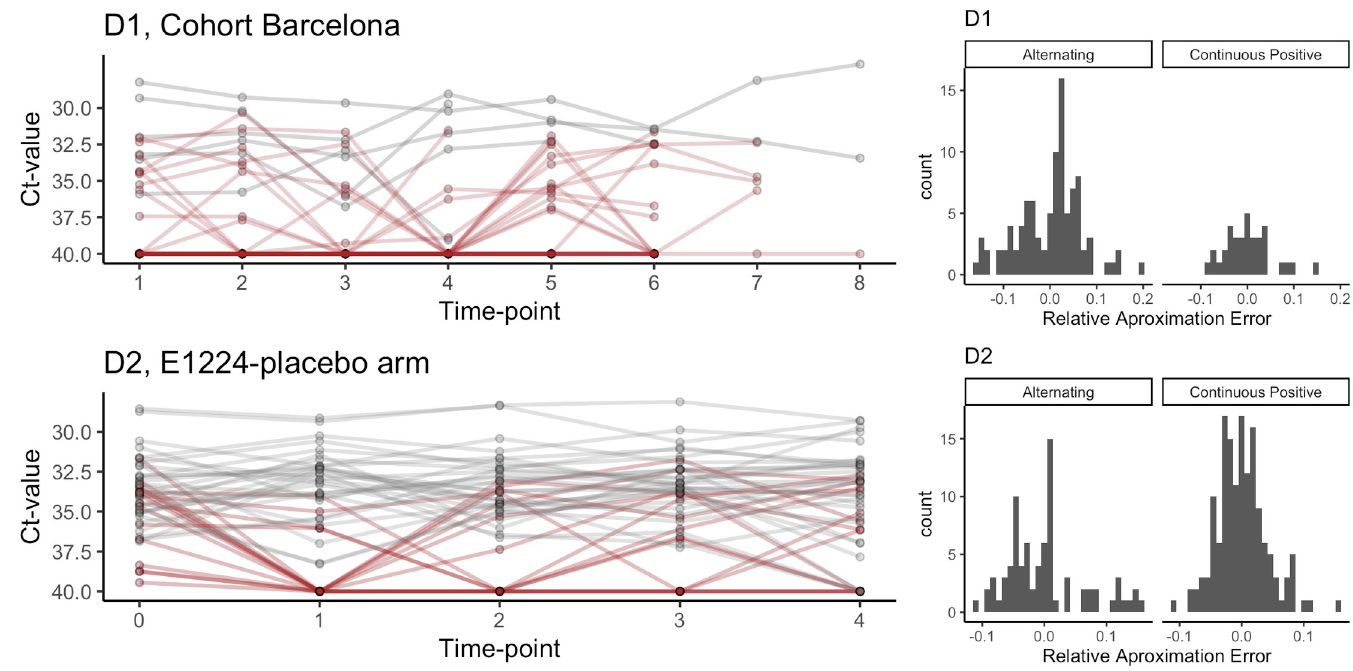
Fig 2. Ct-values as individual trajectories over time for both D1-D2 and percentage error distributions by category. Left row panels showing individual trajectories over time among those with always detectable parasitemia (gray) and those alternating detectable/undetectable parasitemia (red) for D1 (top) and D2 (bottom). Right panels showing the distribution of the approximation errors (as frequencies) relative to each individual series mean Ct-value and disaggregated by category, continuous detectable parasitemia on the left side vs alternating detectable/undetectable parasitemia on the right side—for D1 (top) and D2 (bottom).